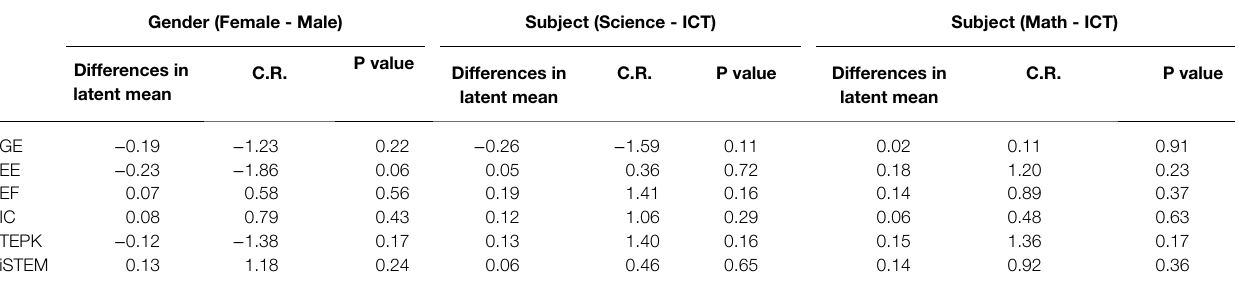
TABLE 5 | Mean differences in gender and subject matters Gender (Female -